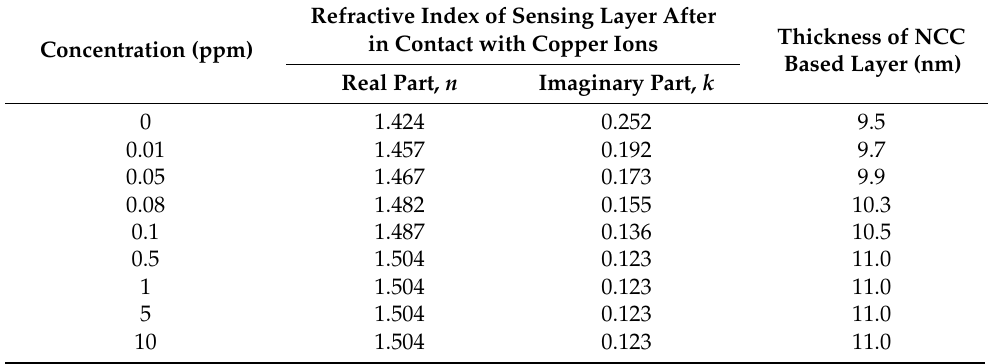
Table 3. Refractive index of the NCC-based layer in contact with deionized water and copper ion.